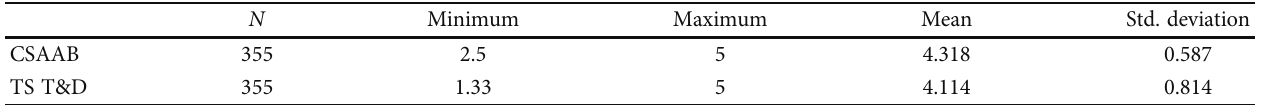
Table 8: Descriptive statistics of the